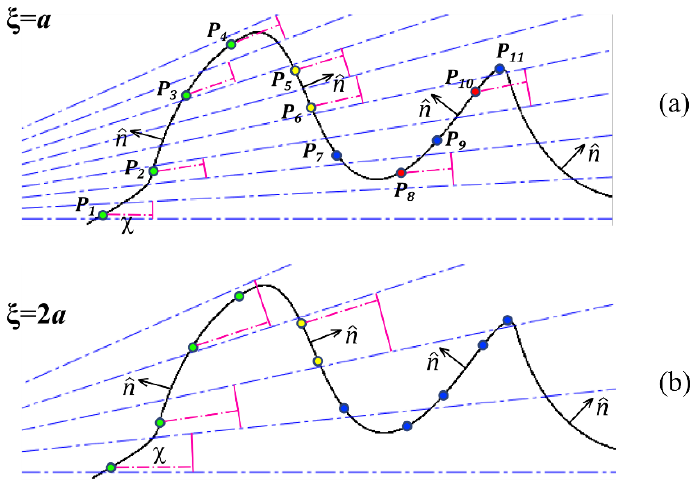
Figure 5. Application of the exclusion methods on a part of a hypothetical surface represented by eleven points, for two values of ξ . The value of ξ in ( b ) is twice the value of ξ in ( a ). Green points: to be maintained; blue points: excluded with the first exclusion; yellow points: excluded with the second exclusion; red points: not correctly excluded with the two exclusions.